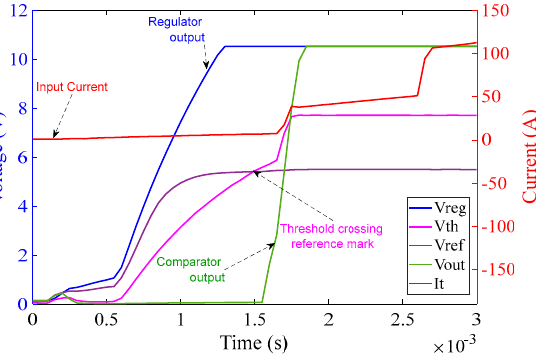
Figure 15. 10 Ω burden circuit operation at 100 A(rms) input current over 3 ms. Figure 15. 10 Ω burden circuit operation at 100 A (rms) input current over 3 ms.